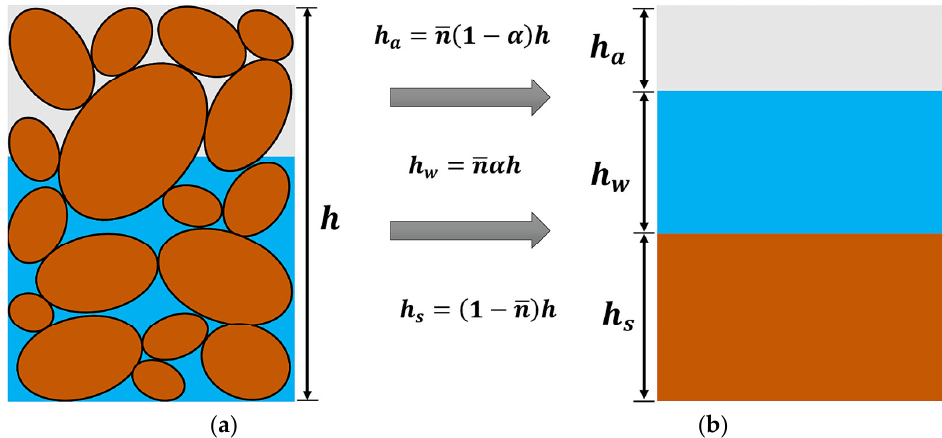
Figure 2. Magnitudes characterizing the partially saturated debris flow components.